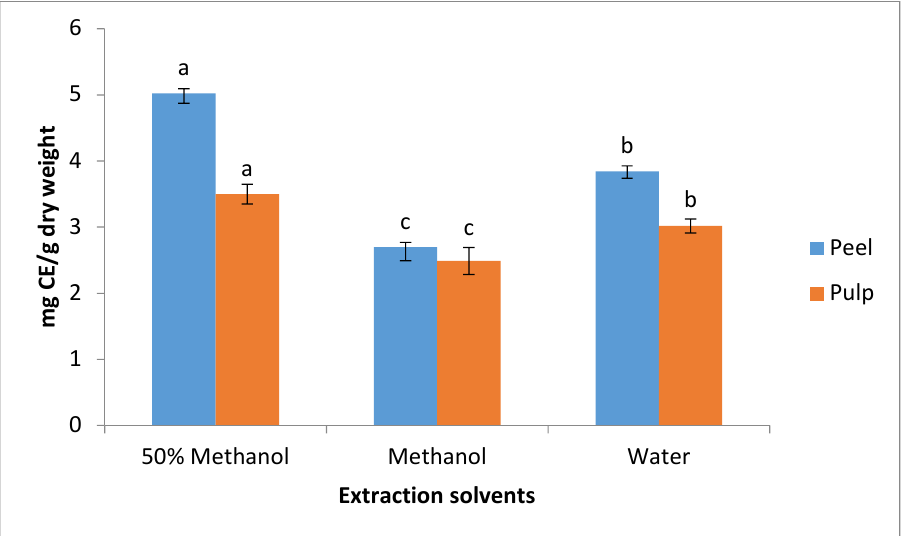
Figure 2. The total flavonoid content of beetroot peel and pulp. The different letters on bars show the significant differences among the extracts for peel and pulp individually ( p < 0.05).